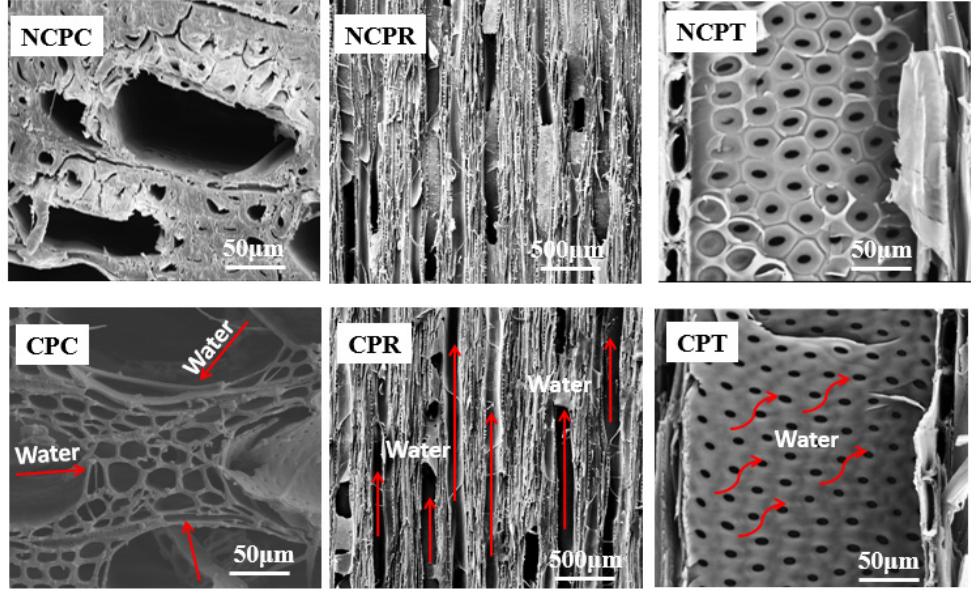
Figure 6. Cross-section, radial section, and tangential section structures of untreated poplar and carbonized surface poplar.